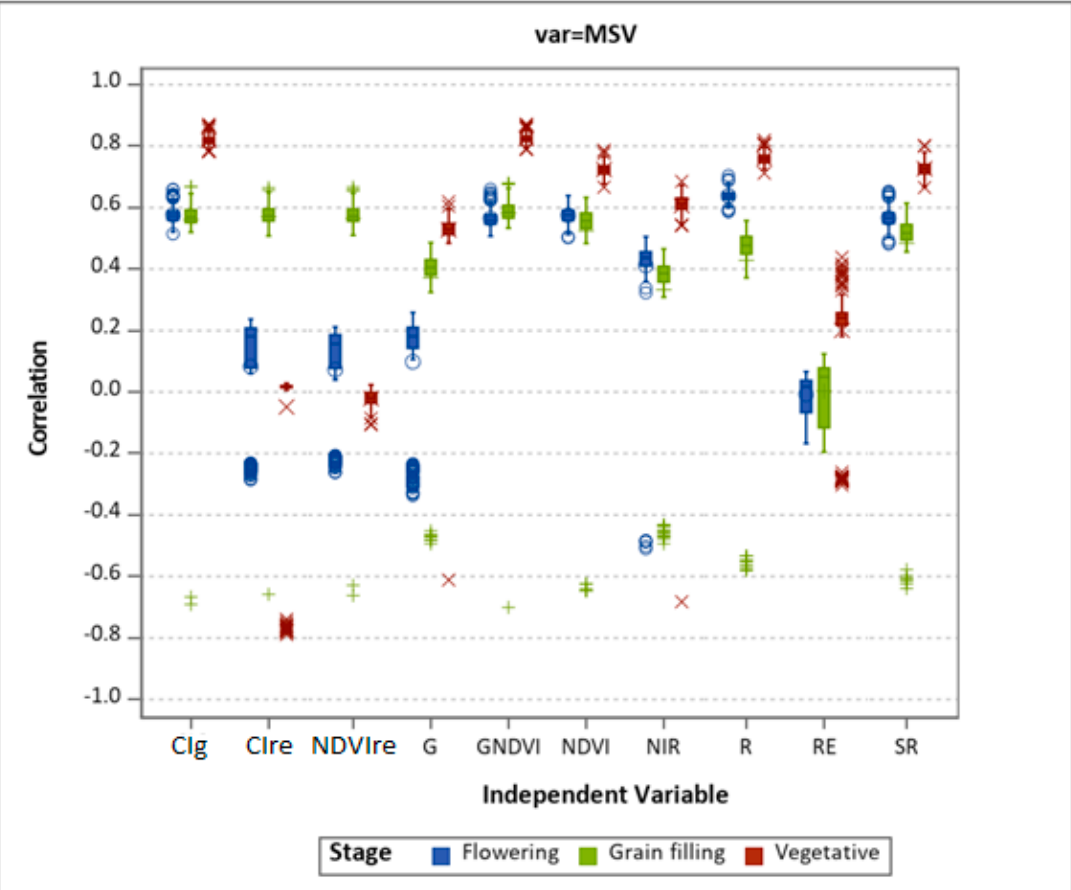
Figure 6. Box plots of correlations for ground truth average MSV measurements and UAV-derived multispectral data. CIg = Green Chlorophyll index; CIre = Rededge Chlorophyll index; NDVIre = Rededge Normalized Difference Vegetation Index; G = Green; R = Red; NIR = Near-Infrared; RE = Rededge; SR = Simple Ration.